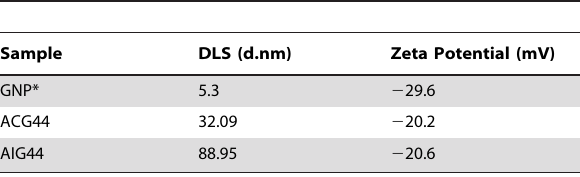
Table 1. Dynamic Light Scattering and Zeta Potential Measurements of GNP (the core particle), ACG44 and